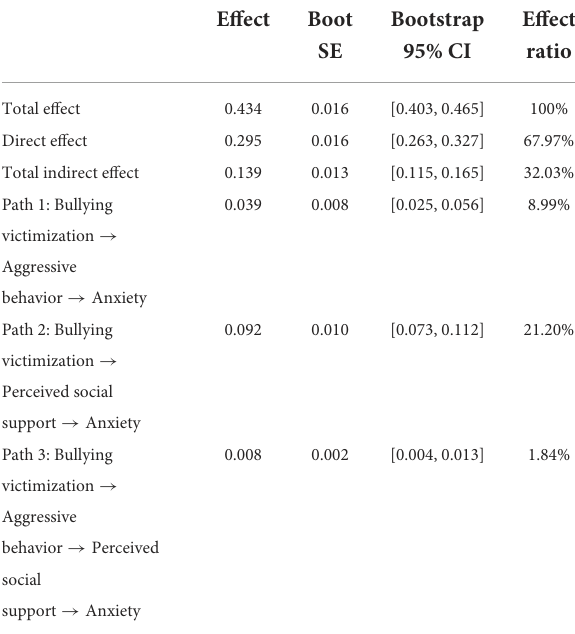
TABLE 5 Mediating effect analysis of bullying victimization and anxiety.